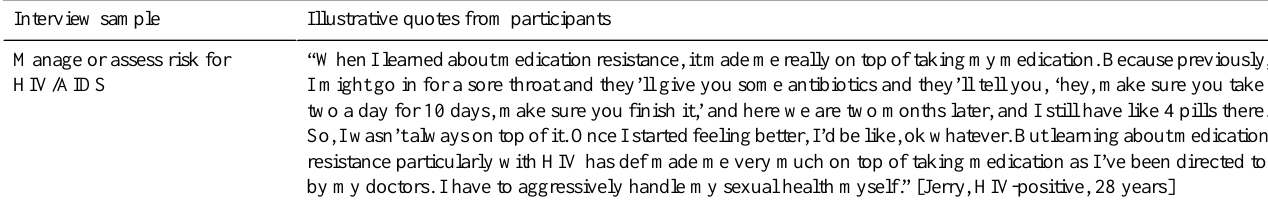
Table 5. HIV information use—interview sample (n=22).